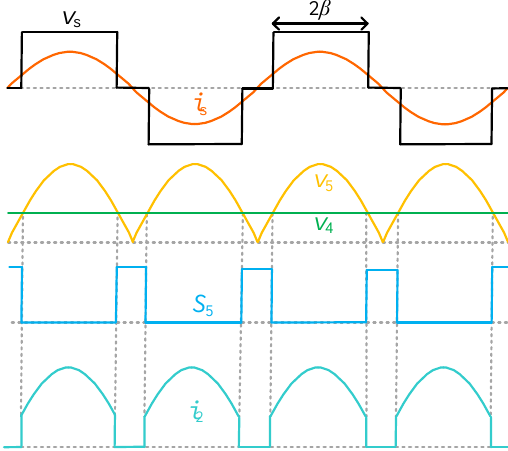
Figure 8. Typical waveforms of APC receiver. i s , secondary resonant current (orange line); v s , secondary resonant voltage (black line); v 4 , feedback signal (green line); v 5 , half-wave signal (yellow line); S 5 , gate drive signal (blue line); i 2 , current flowing through D 5 (light green line). The CC and CV power transfer modes can be achieved through the proposed analog controller.